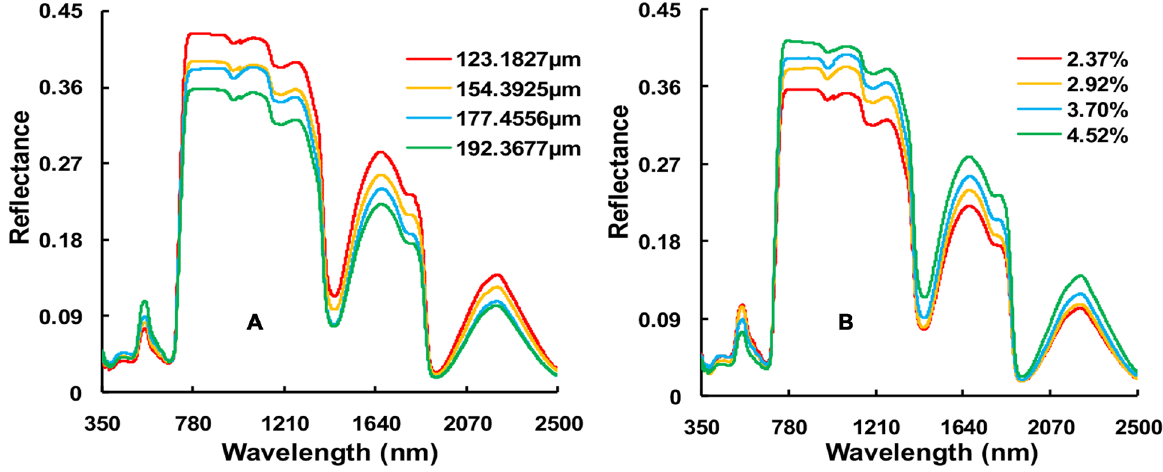
Figure 2. Reflectance of leaves under different LEWT at N2 (A) and LNC at W4 (B) in Exp. 1.